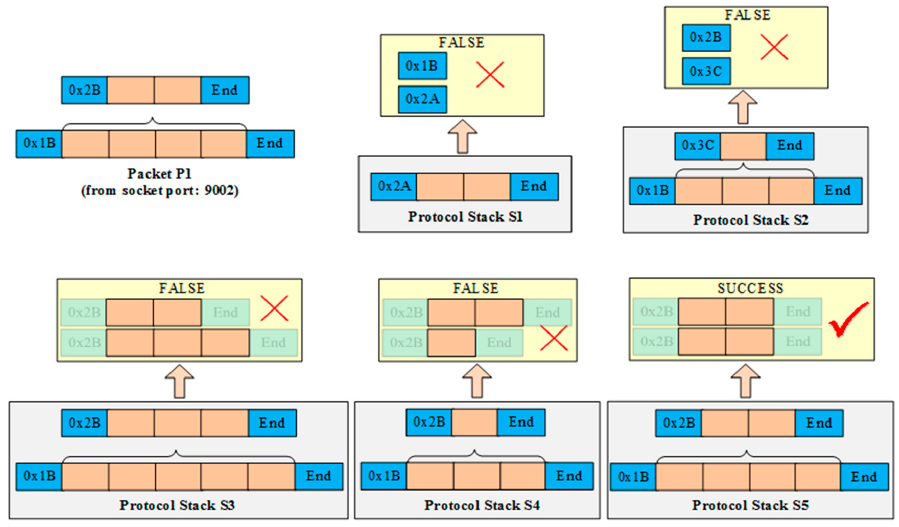
Figure 5. An example of judging which protocol stack could correctly parse a new packet.